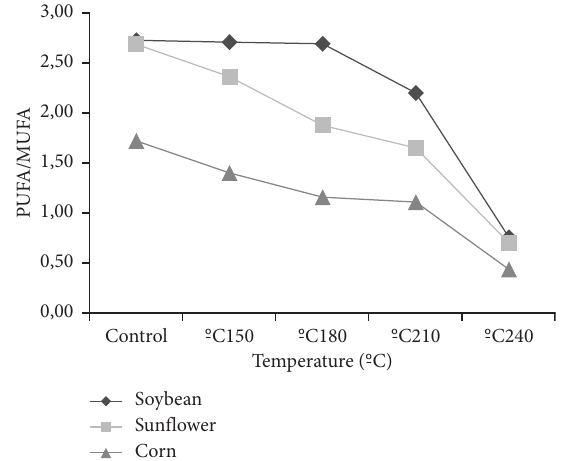
Figure 6: Evolution of PUFA/MUFA ratio of soybean, sunflower, and corn oils after 60 hours of heating. PUFA: polyunsaturated fatty acids and MUFA: monounsaturated fatty